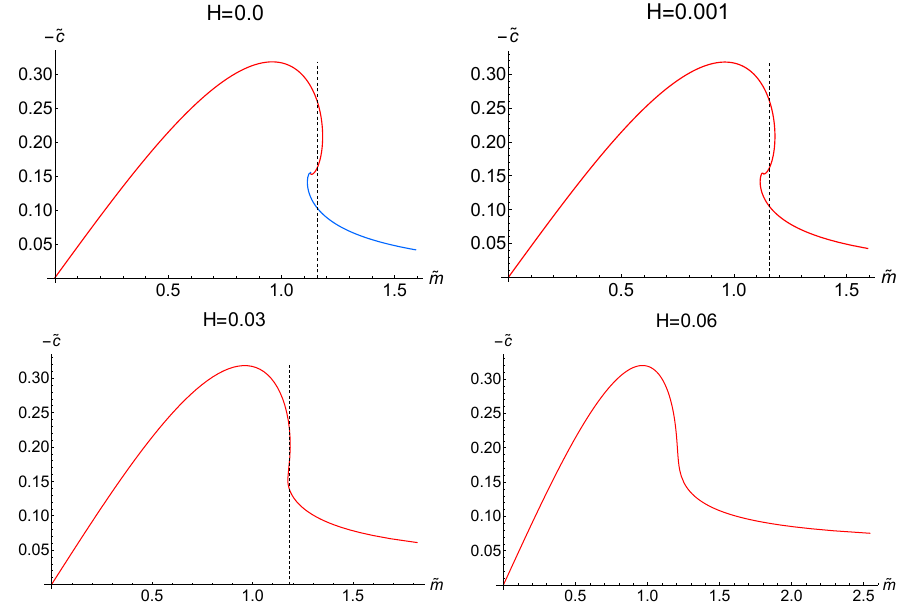
Figure 3. Plots of ~ c as a function of the bare mass parameter ~ m . For small H there is a clear (cid:0) (cid:12)rst order phase transition pattern, which is less pronounced as H and for larger H is replaced by a crossover. The dashed vertical line represent the critical parameter ~ m cr at which the phase transition takes place.